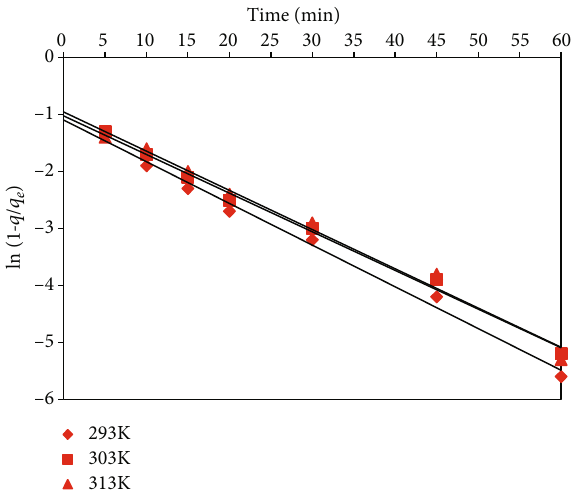
Figure 15: Film di ff usion model for CV adsorption onto ACMAS (CV dye concentration = 25mg/L , pH = 6 : 0 , and time = 60 min ,